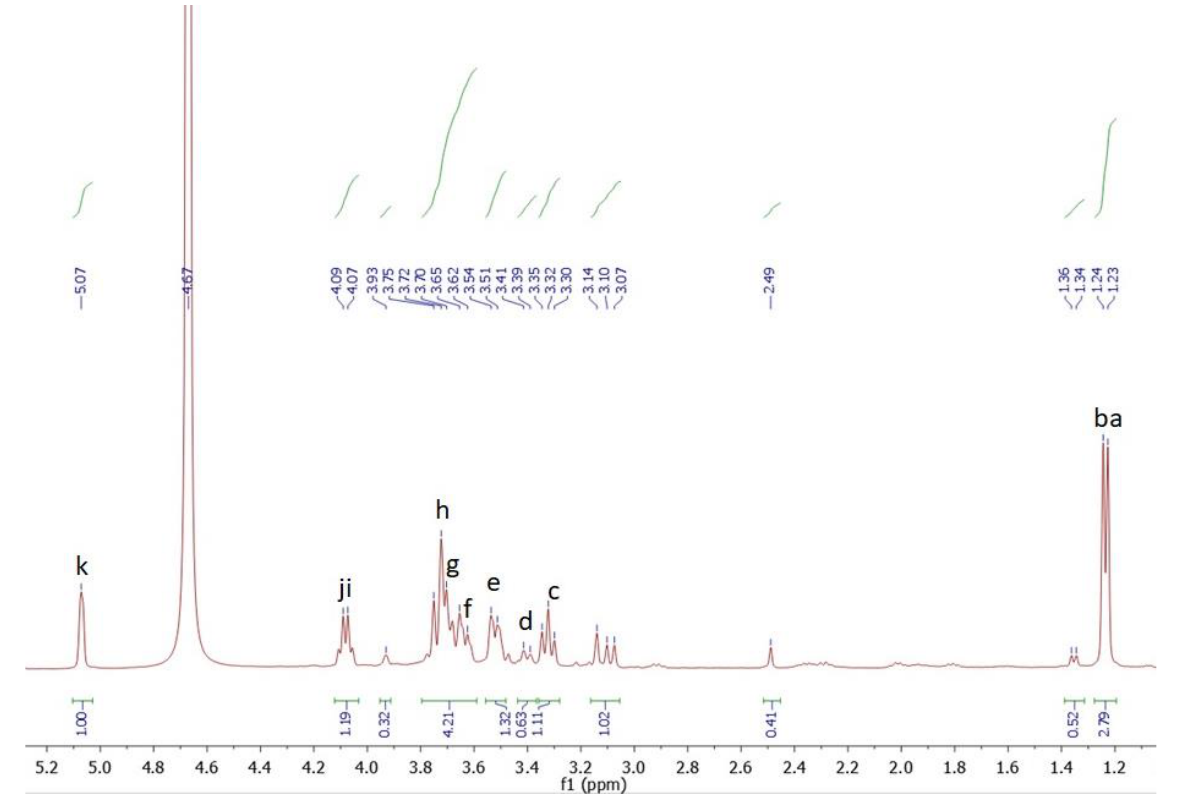
Figure 8. 1H NMR spectroscopy of PNP-80. a – k : Matching lowercase letters represent hydrogen signals at different positions on the PNP-80 structure.